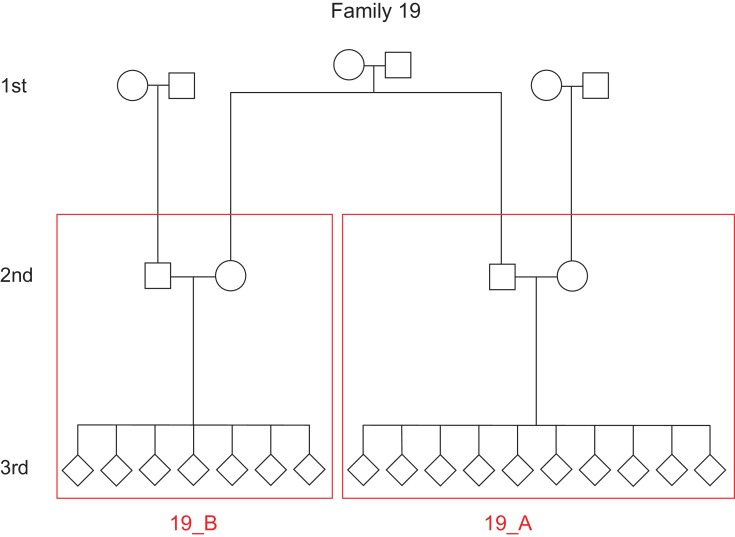
Defining unique families in the CEPH/Utah dataset.The pedigree for a single family (family ID 19) is depicted. In this family, the third-generation individuals are first cousins and share a pair of grandparents. However, for the purposes of the inter-family variability presented in Figure 3, we defined ‘families’ as the unique groups of second-generation parents and their third-generation children. Thus, family ID 19 would be split into two unique families (19_A and 19_B), designated by the red boxes.